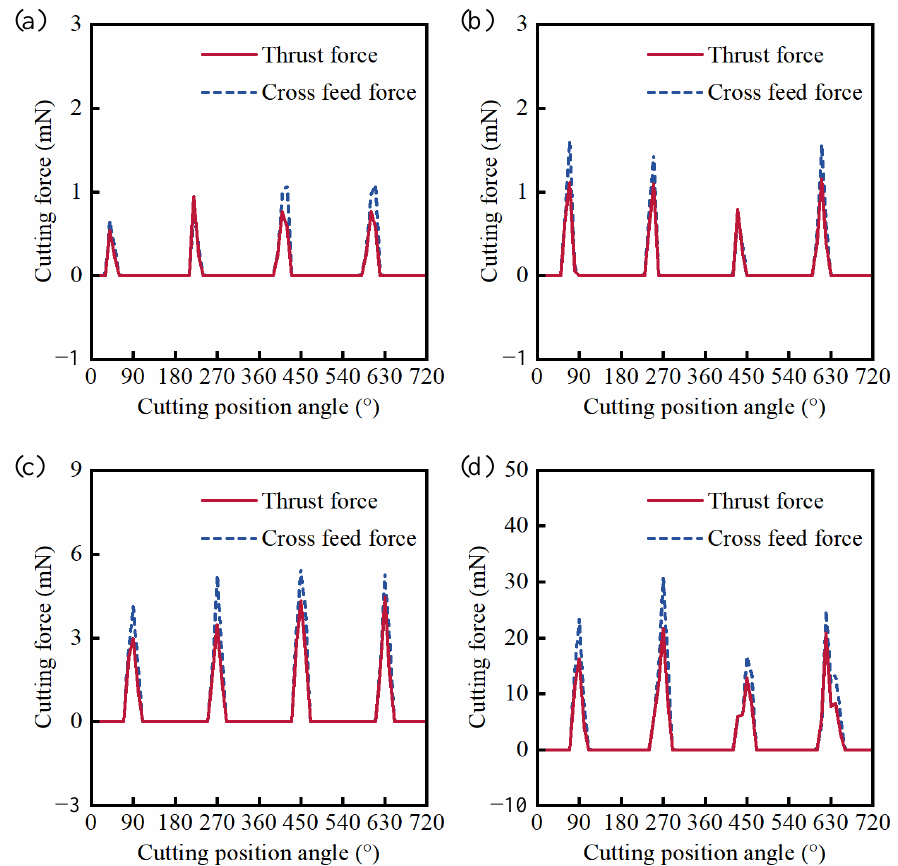
Figure 7. (Scratched surface) Simulated results of cutting force with cutting edge rotation angle under f t / r e : ( a ) f t = 0.27 µm/z, f t / r e = 0.15; ( b ) f t = 0.46 µm/z, f t / r e = 0.25; ( c ) f t = 1.37 µm/z, f t / r e = 0.75; ( d ) f t = 5.46 µm/z, f t / r e = 3.0.